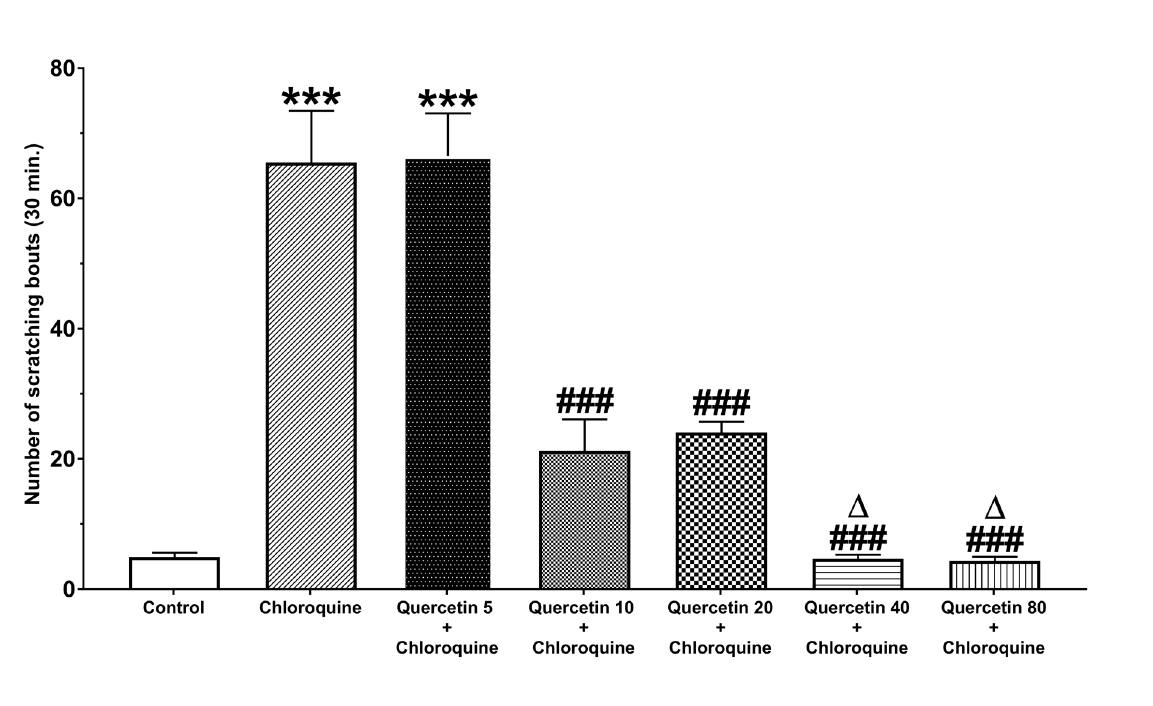
FIGURE 2 - Effect of quercetin on chloroquine-induced increase in the number of scratching bouts. All investigated doses significantly suppressed chloroquine-induced scratching except 5 mg/kg treatment. But that suppressive effect was found to be stronger in the 40 and 80 mg/kg doses. All data represented as mean±SEM. ***p<0.001 versus control and ###p<0.001 versus chloroquine and Δp<0.05 versus quercetin 20 mg/kg